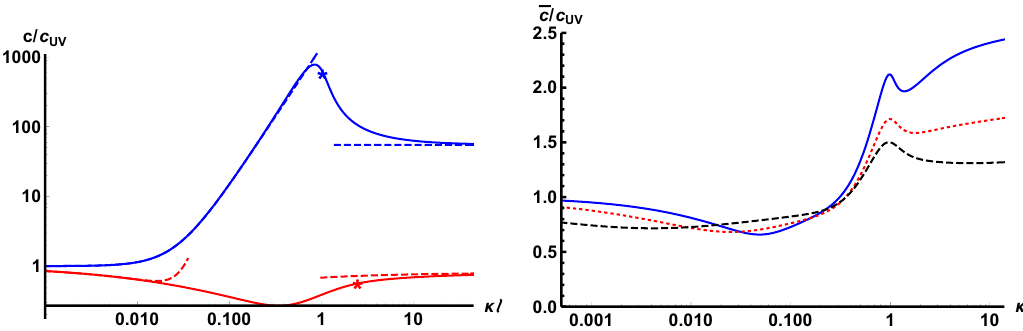
Figure 6 . Left: the c -functions for the in-plane ( k ,blue) and o(cid:11)-plane ( ? ,red) directions at Q f = 1 and n = 1 = 2, m = 2 as functions of ‘ and ‘ ? , respectively. The dashed curves are the analytic k UV and IR expansions. Right: we depict the average (cid:22) c -functions (3.37) for n = 1 = 3 (solid blue), n = 1 = 2 (dotted red), and n = 2 = 3 (dashed black) for Q f = 1, m = 2, and (cid:22)R 2 =‘ 0 = 1. Notice the log-linear